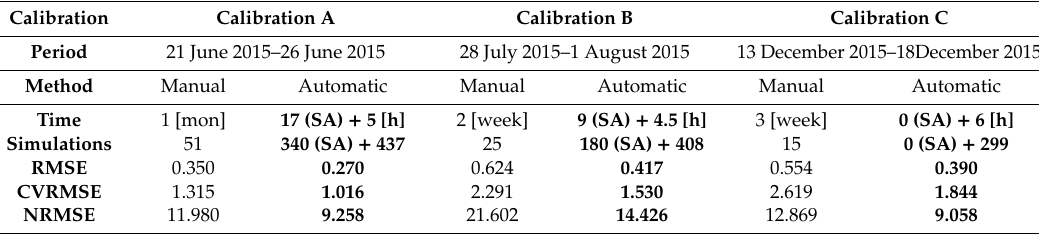
Table 15. Multi-stage calibration results comparison for manual and automatic methods. In bold the best